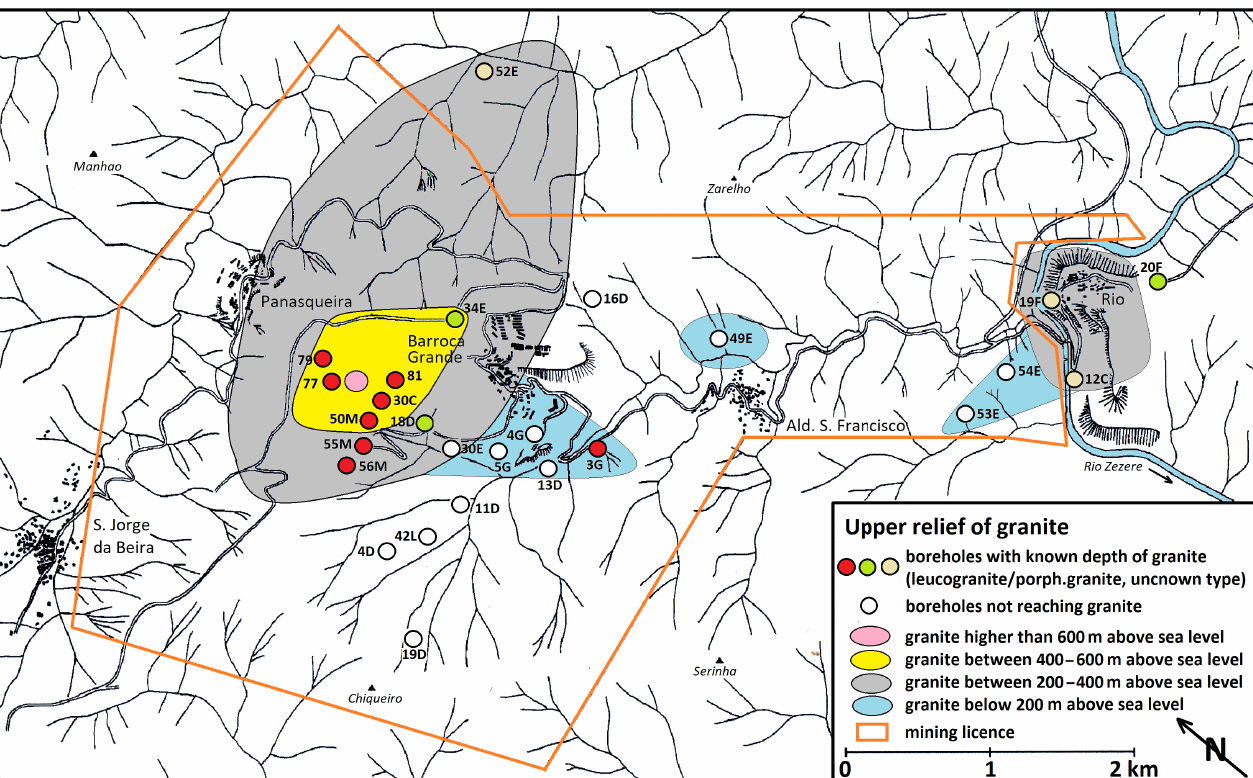
Figure 1. A schematic shape of the hidden Panasqueira pluton based on information from the mine and the boreholes. Rem.: black double line—road, black dots—buildings, black-blue double line—river Zezere, thin black lines-